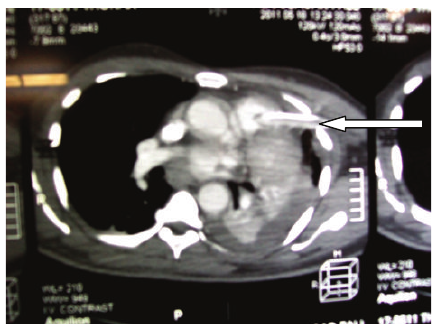
Figure 1: Chest tube inside pulmonary artery.